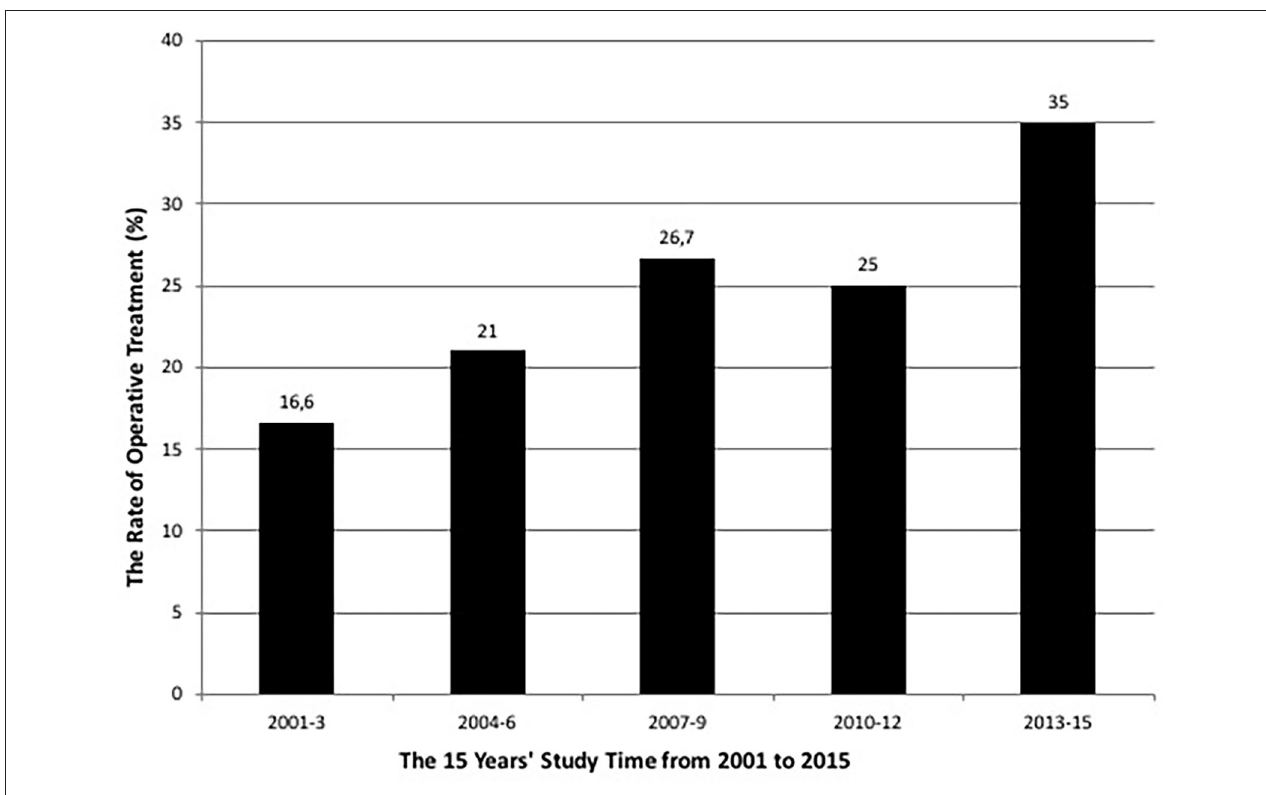
FIGURE 1 | The rate of surgical treatment of the patients during the 15 years’ study period from 2001 to 2015. The surgical treatment increased during the study